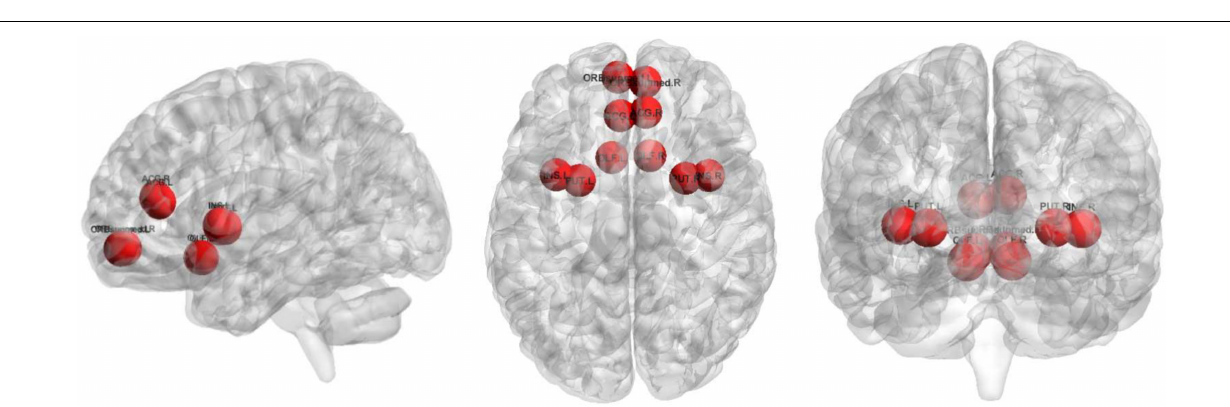
FIGURE 8 | The top 10 nodes (ROIs) of the Lo-FGN screened by the SA-GCN architecture.